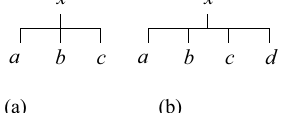
Table 3 Potential functions, bifurcation sets, and normalization formula CPM Numbers of control Potential functions Bifurcation sets Nor- variable